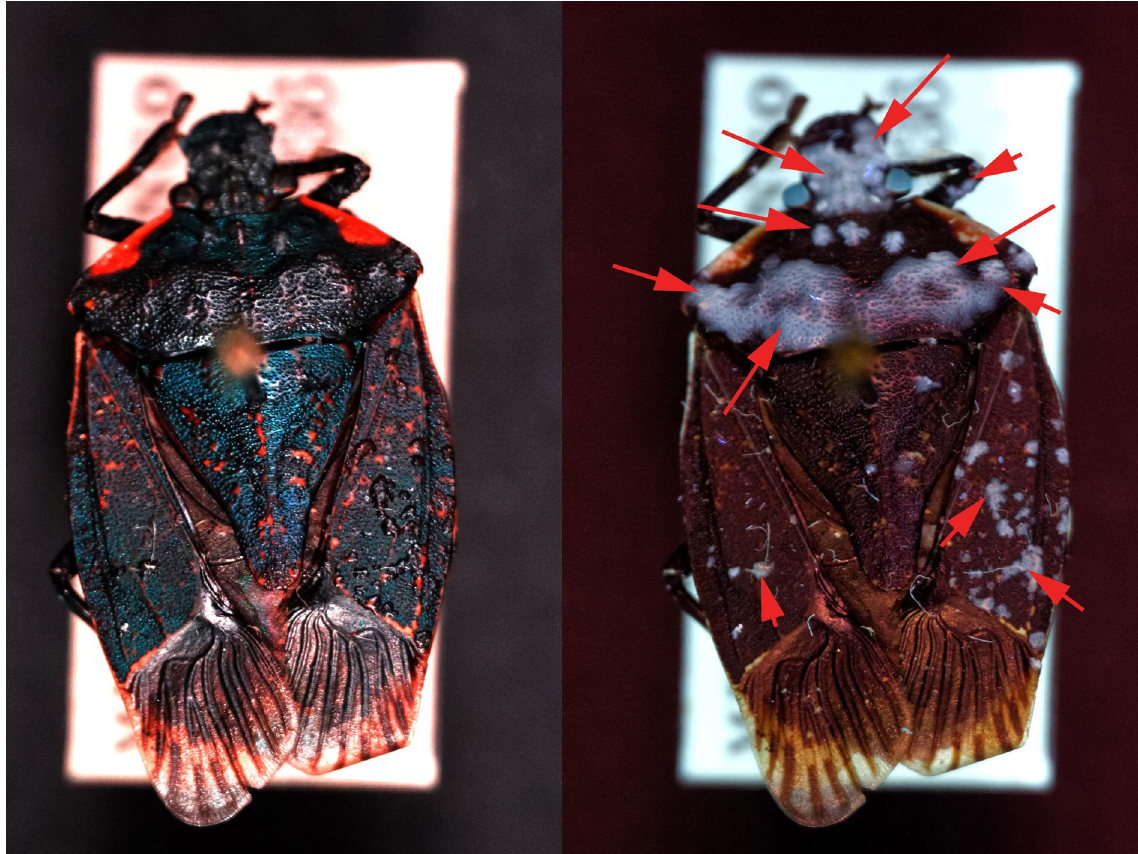
Fig. 4.4. Specimen of the Pentatomidae, Halyomorpha sp. On the left in white light, on the right under UV fluorescence. The red arrows show the parts affected by fungus on the specimen, that are only visible in UV fluorescence.